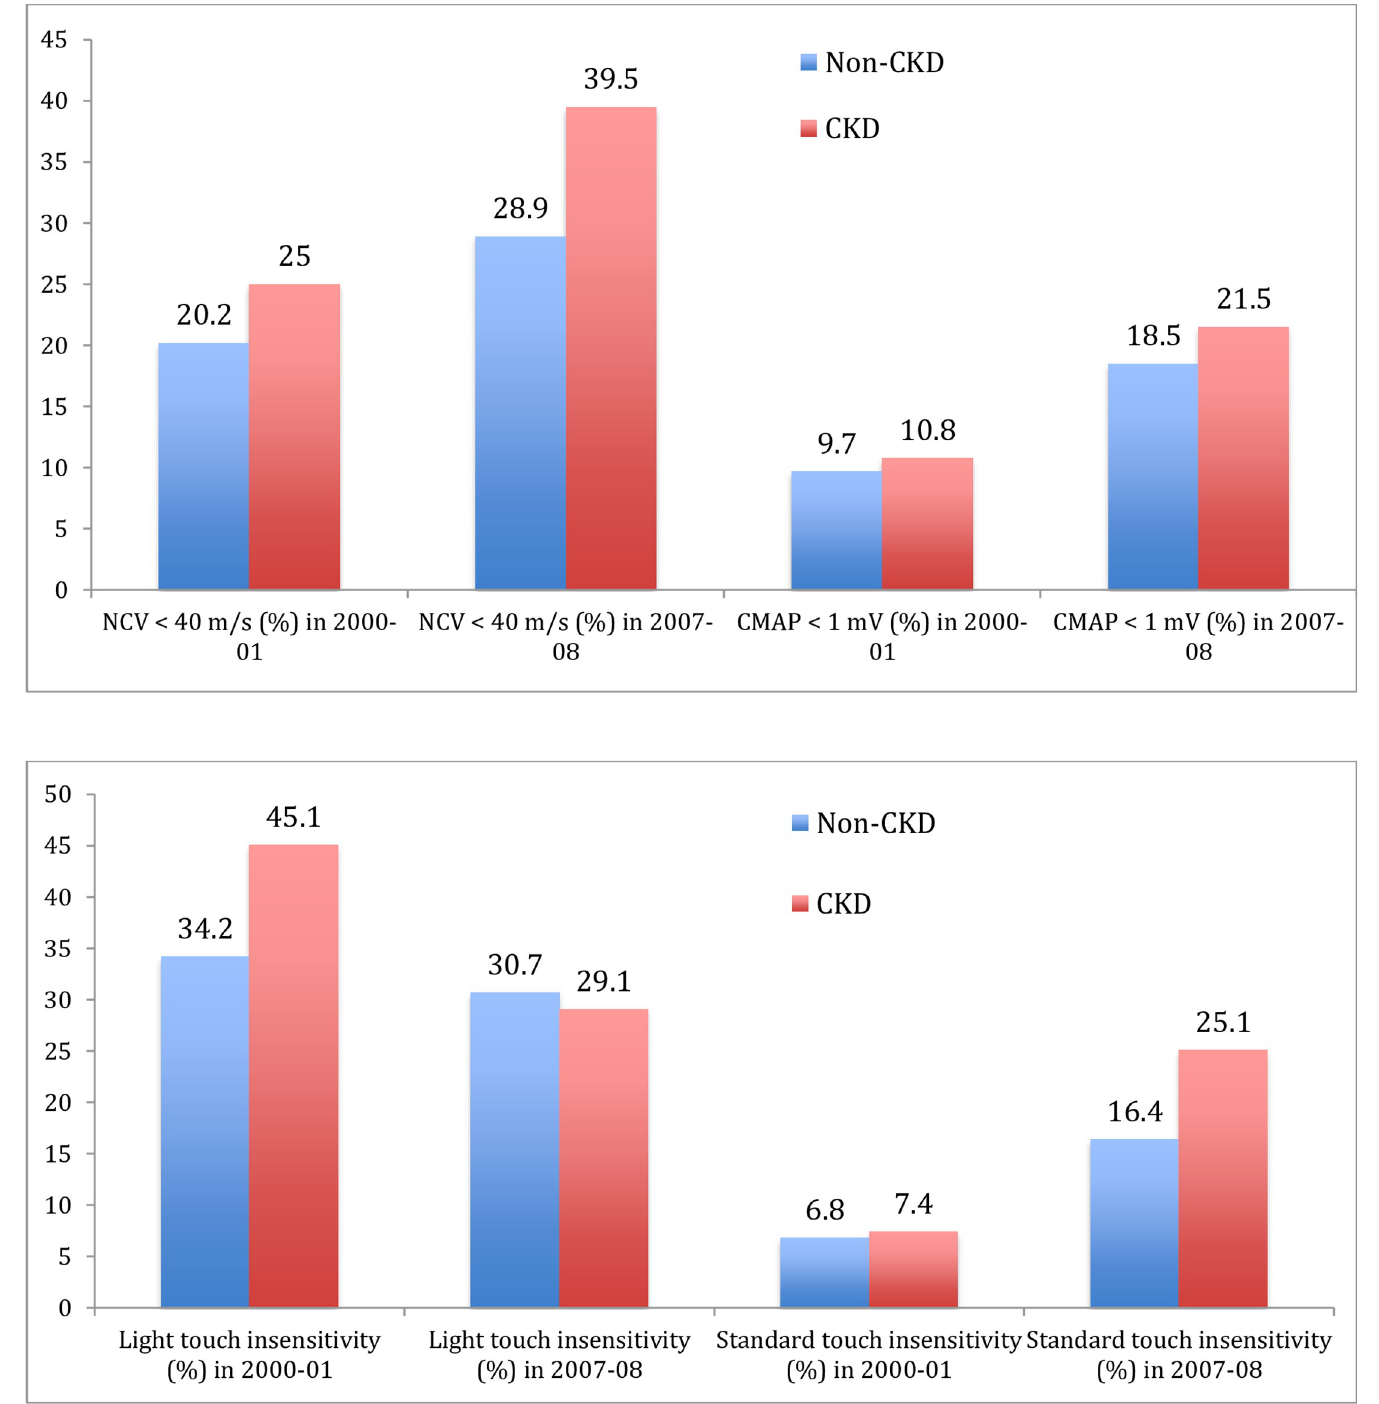
Fig 2. Point prevalence of motor (A) and sensory (B) Nerve function impairments at years 2000–01 and 2007–08 by presence of CKD in 1999–2000.